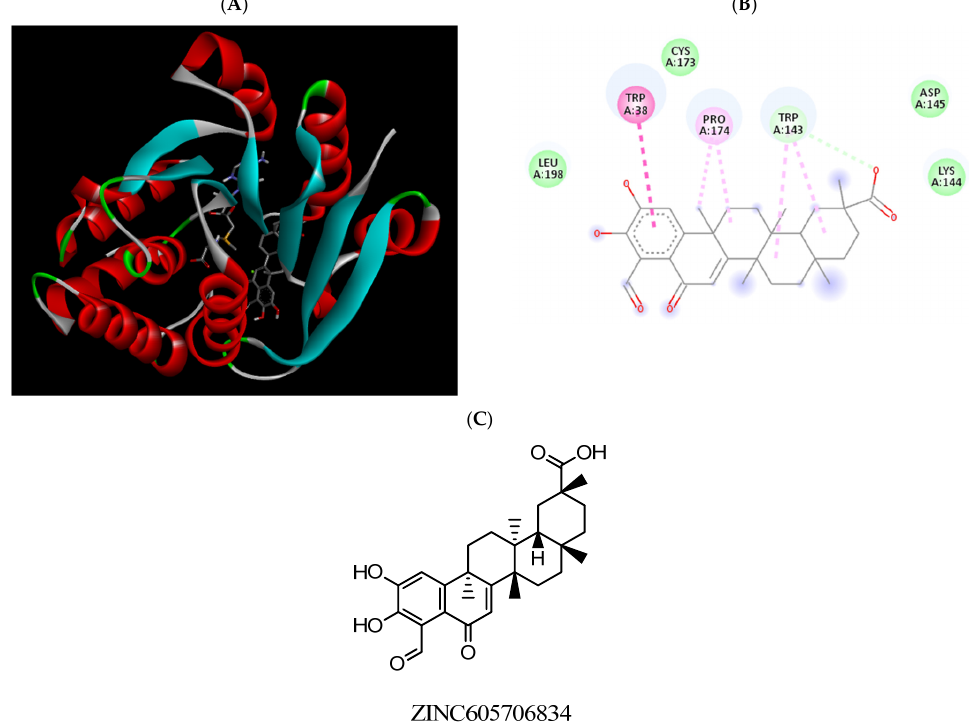
Figure 11. ( A ) Binding modes of ZINC605706834 with the crystal structure of human COMT complexed with SAM and Mg 2+ , ( B ) receptor–ligand interactions, ( C ) 2D representation of ZINC605706834.